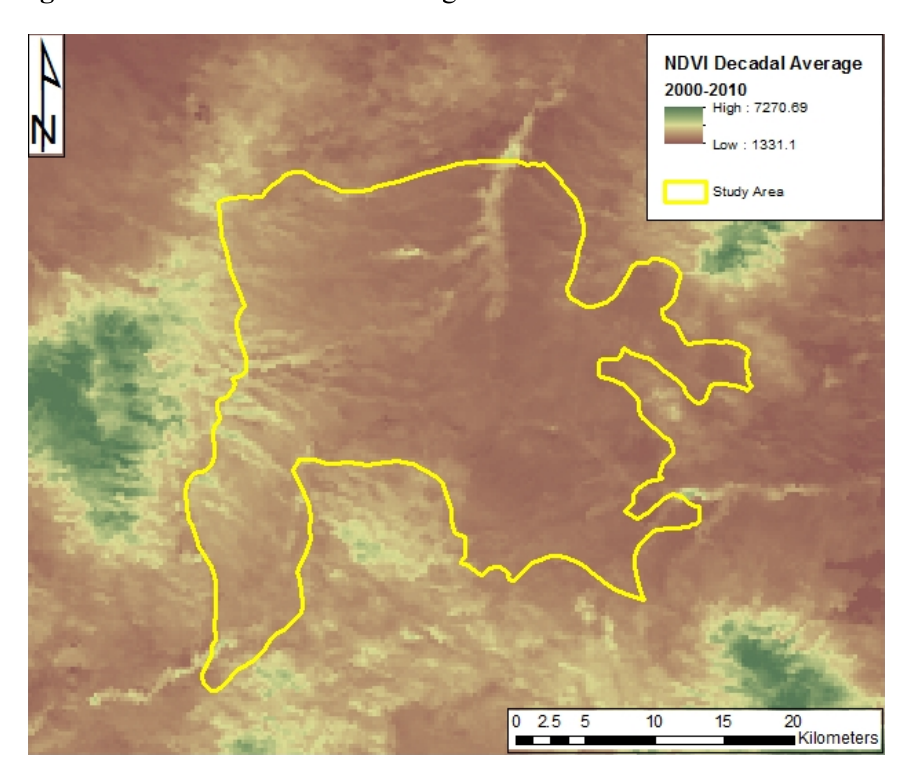
Figure 2. 2000–2010 decadal average NDVI values for the Sonoita